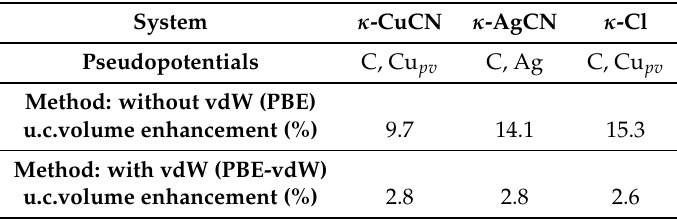
Table 1. Unit cell volume enhancement (in %), defined as relative deviation from the experimental value, of κ -CuCN, κ -AgCN, and κ -Cl, obtained from ab initio calculations without van der Waals (vdW, based on PBE functional) and with vdW (based on the PBE-vdW functional). Pseudopotentials used for each system are